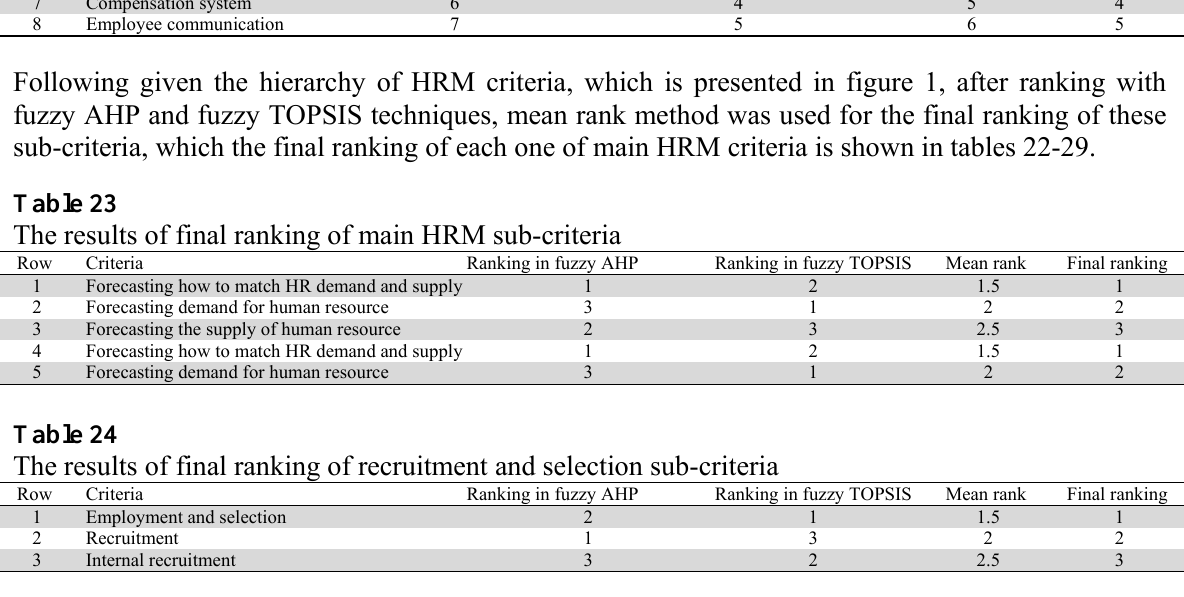
The results of final ranking of main HRM criteria Row Criteria Ranking in fuzzy AHP Ranking in fuzzy TOPSIS Mean rank Performance evaluation Job design Human resource planning Recruitment and selection Employee health and hygiene Training and development Employee communication